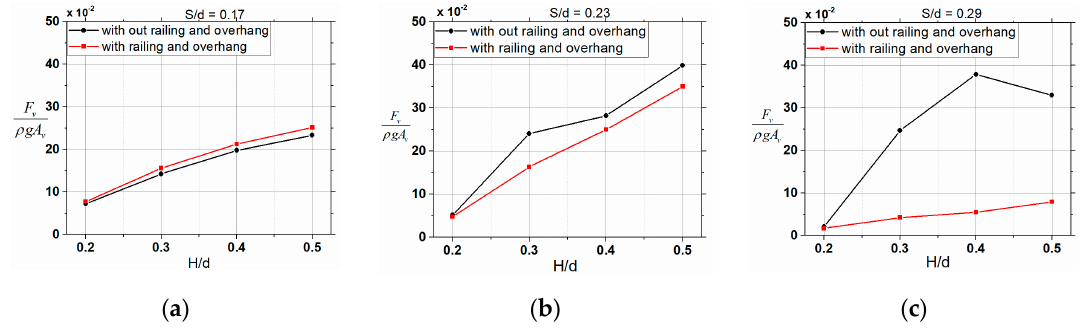
Figure 14. Comparison of peak vertical impact force for deck with and without railing and overhang for different H/d ratios and airgaps ( a ) S/d = 0.17, ( b ) S/d = 0.23 and ( c ) S/d = 0.29.